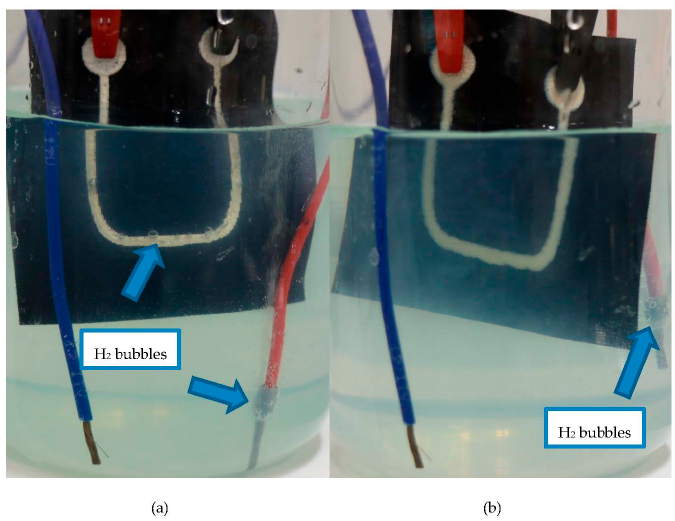
Figure 8. Pinhole test on printed samples. Conductive layer coated with single layer ( a ) and double layer ( b ) of protective coating.